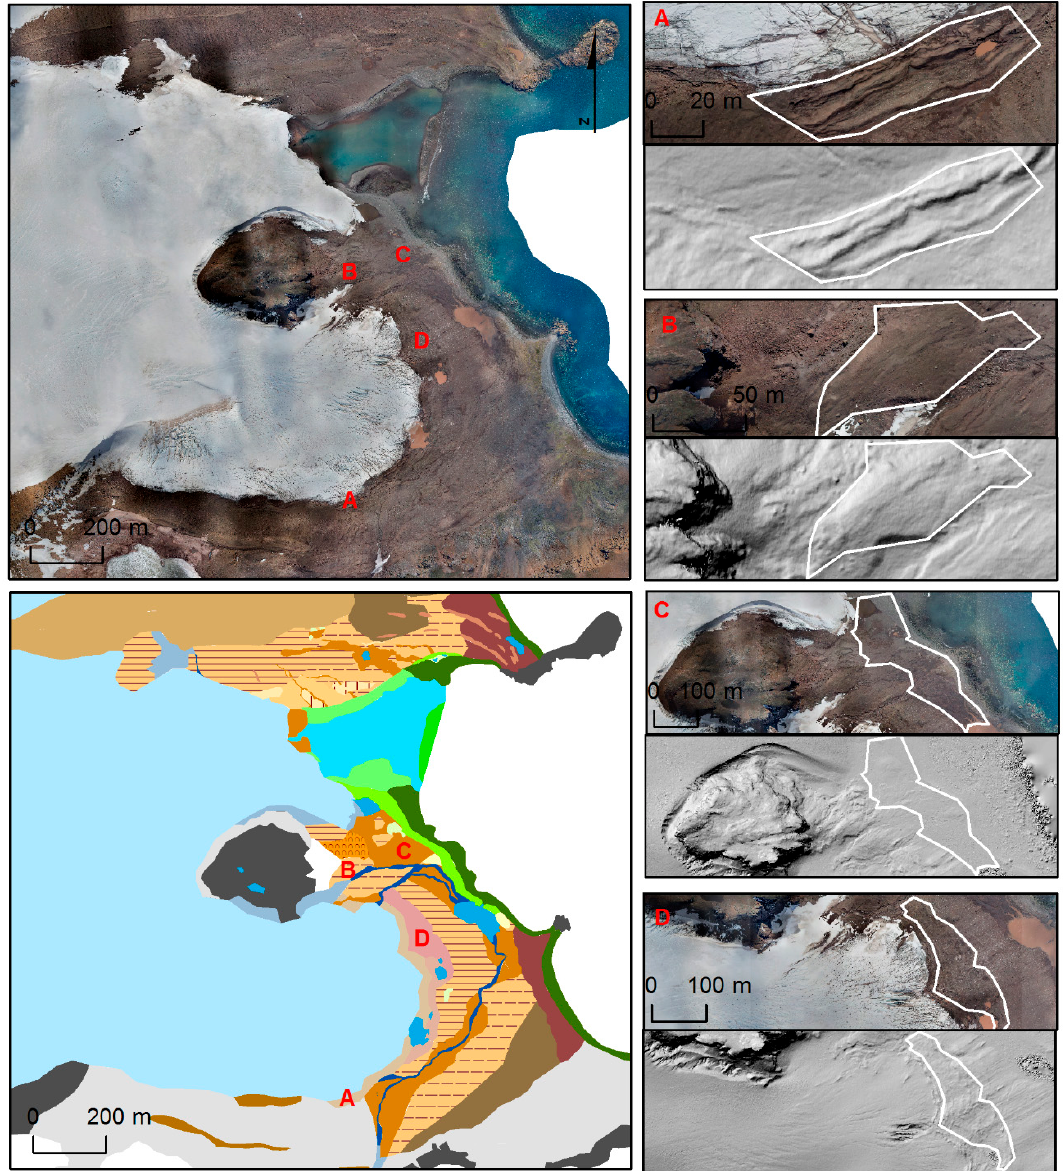
Figure 10. Baranowski Glacier foreland: an orthophoto and a detailed geomorphological map (see Figure 6 for legend), and examples of vectorized landform units (white polygons) based on the orthophoto and the Digital Elevation Model; A—contemporary end moraine complex; B—ground moraine, C—outwash, D—fluted end moraine complex.